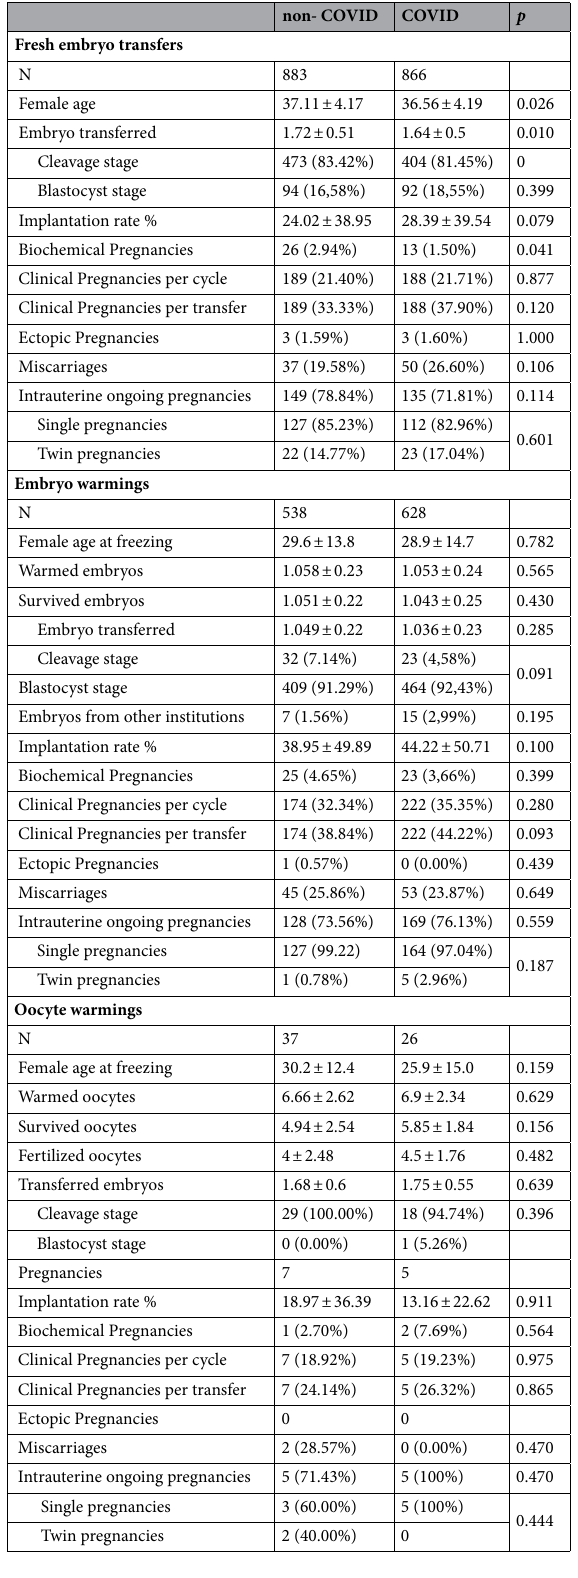
Table 2. ART cycles outcomes in fresh, warmed embryos and warmed oocytes in the non-COVID and COVID-19